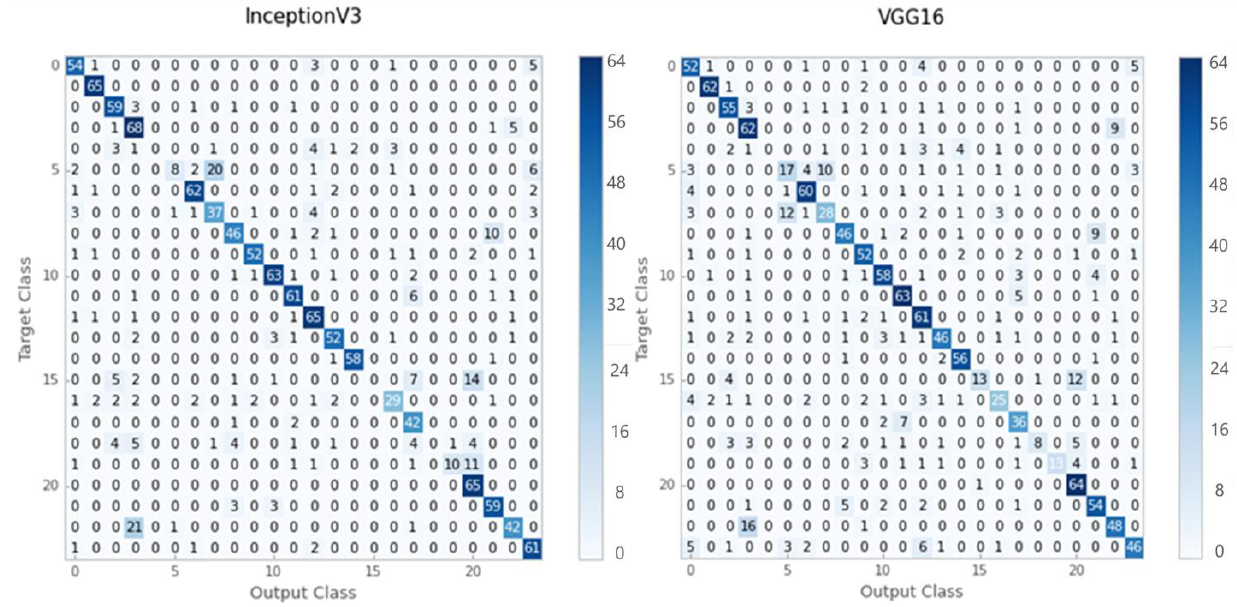
Figure 4. The confusion matrixes for the Inception-V3 and VGG16 pre-trained models.